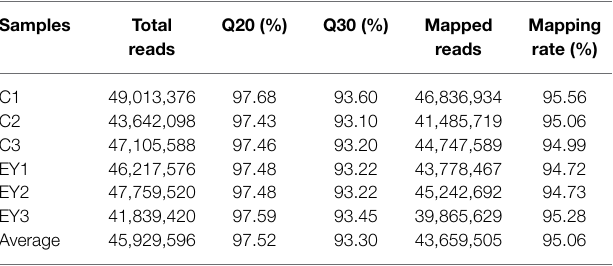
TABLE 1 Statistical analysis of reads mapped to the reference genome after rRNA